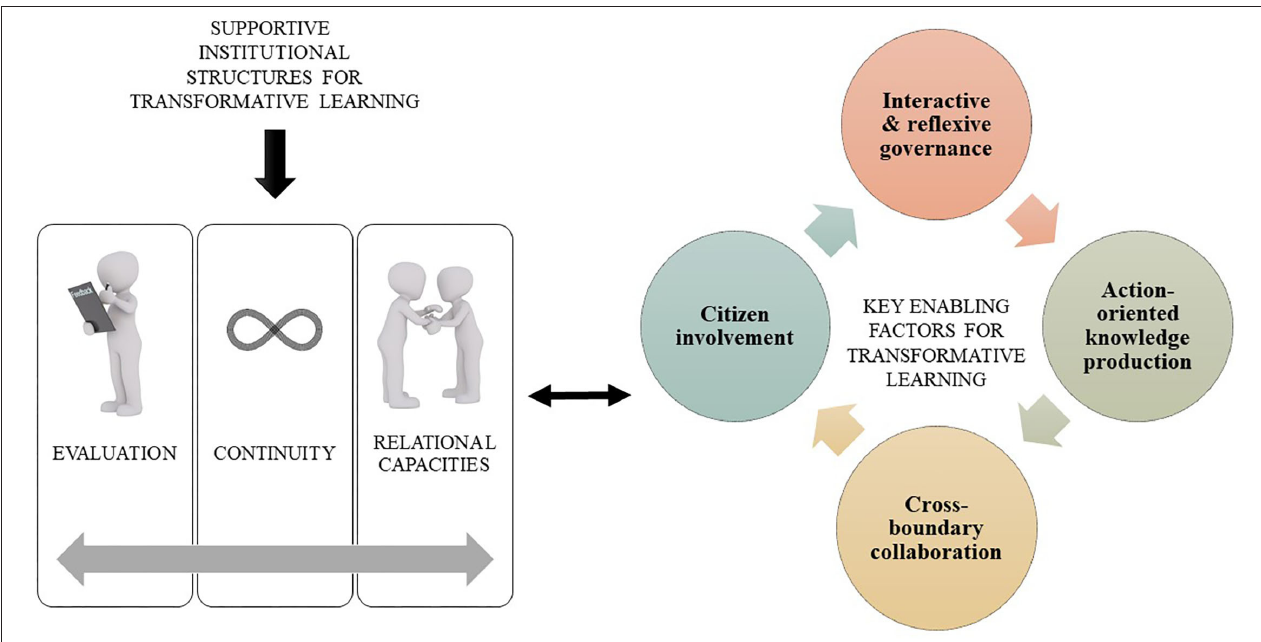
FIGURE 4 | Key enabling factors, or seeds, and supporting conditions for transformative learning which could be integrated in future implementation of NBS for continuous and systemic learning for nature-based urban transformations.